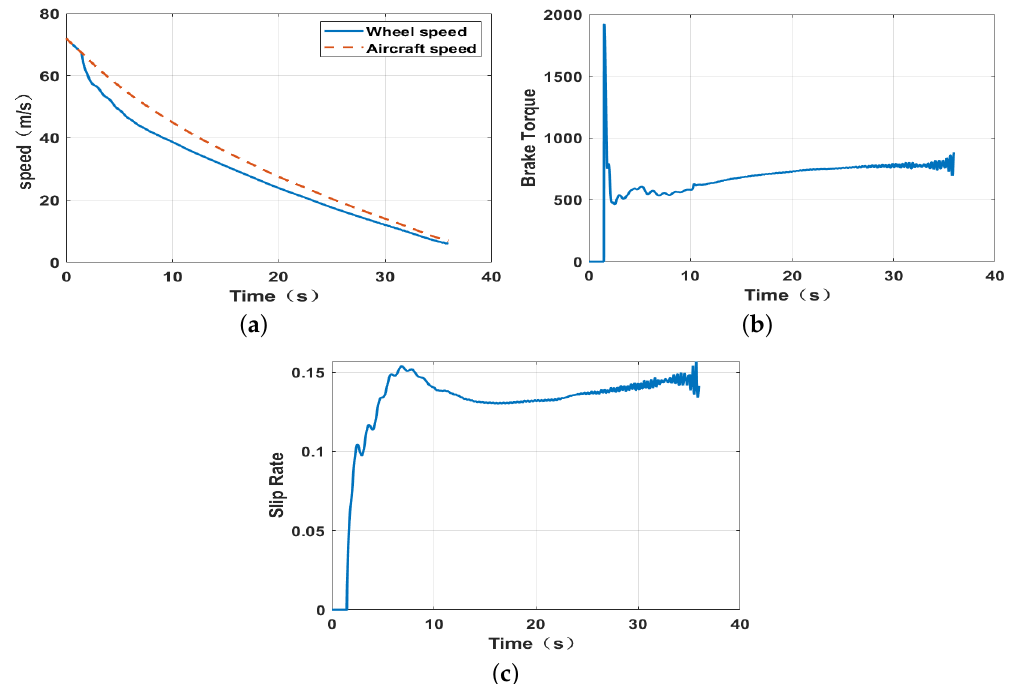
Figure 16. Braking test of the proposed controller on an ice runway. ( a ) Aircraft velocity and wheel velocity. ( b ) Brake torque of the controller. ( c ) Slip rate of the